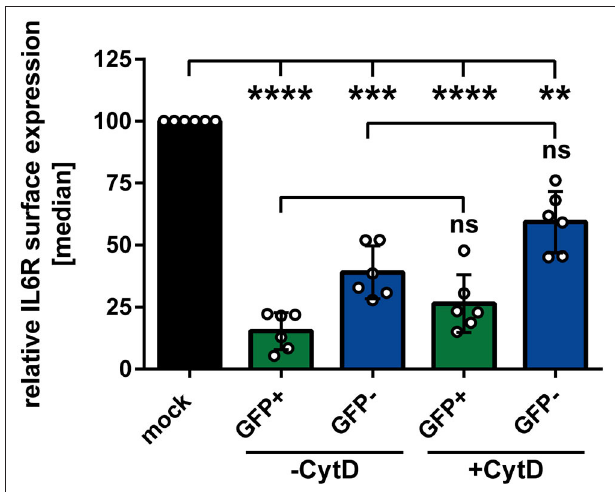
FIGURE 3 | Modulation of IL6R surface expression on bystander mDCs is independent from phagocytosis. Mature DCs were mock- or HSV-1 wt-infected (MOI of 0.65), treated with or without Cytochalasin D (CytD) from 1 hpi ongoing and harvested 16 hpi. Cells were stained with an IL6R-specific antibody for subsequent flow cytometric analyses. Distinction between infected and uninfected mDCs is based on the GFP signal and the used gates in data evaluation software FCS Express 5, which are specific for either the GFP-positive or GFP-negative population. The median of IL6R surface expression was normalized to mock expression levels. The experiment was performed six times with cells derived from different healthy donors. Error bars indicate SD. Significant changes were analyzed using a one-way ANOVA and Bonferroni multiple comparison post hoc tests and are indicated by asterisks (** p ≤ 0.01, *** p ≤ 0.001, **** p ≤ 0.0001). Not significant changes ( p > 0.05) are depicted as